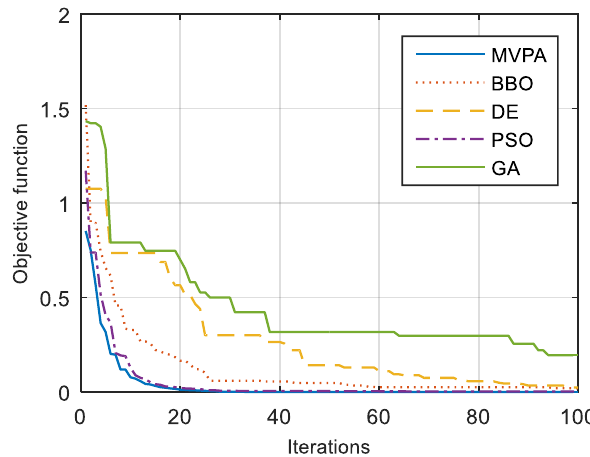
Figure 4. Evolution of the objective function versus iterations for case Figure 3. Evolution of the objective function versus iterations for case 1. Table 1. Comparison of actual locations with those obtained using different algorithms for case 1.